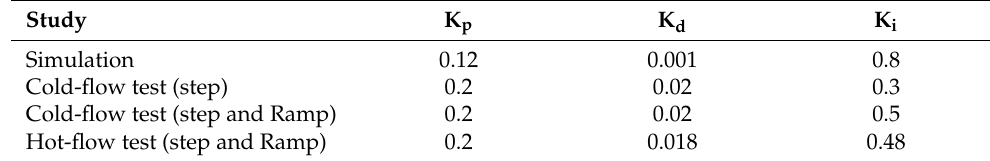
Table 5. PID control